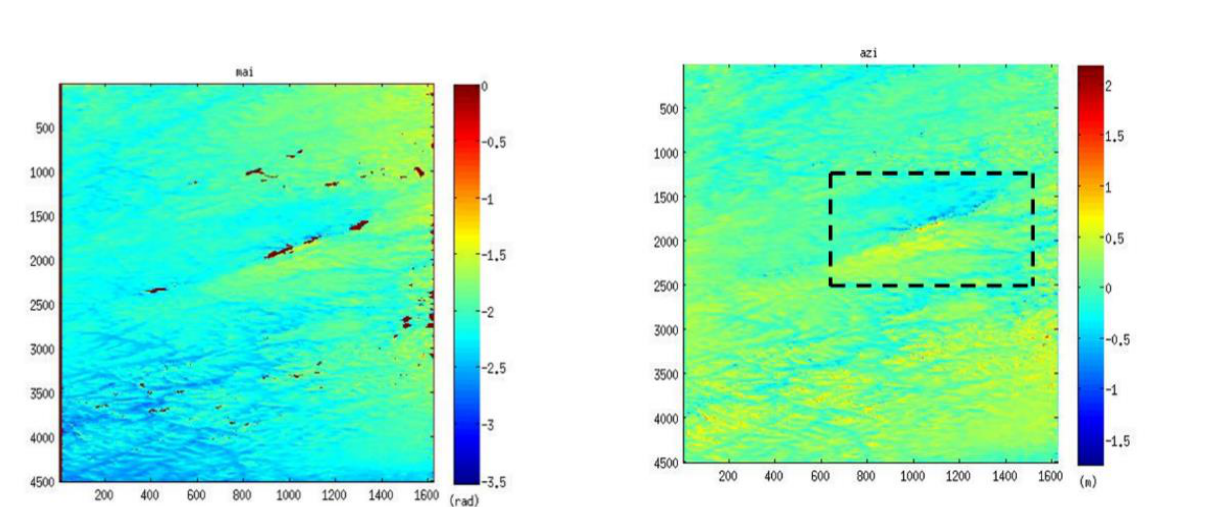
Figure 1. Co-seismic displacement field in the LOS direction